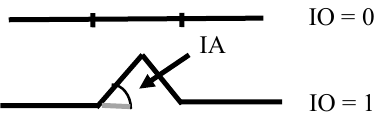
Figure 1. Koch curve generation